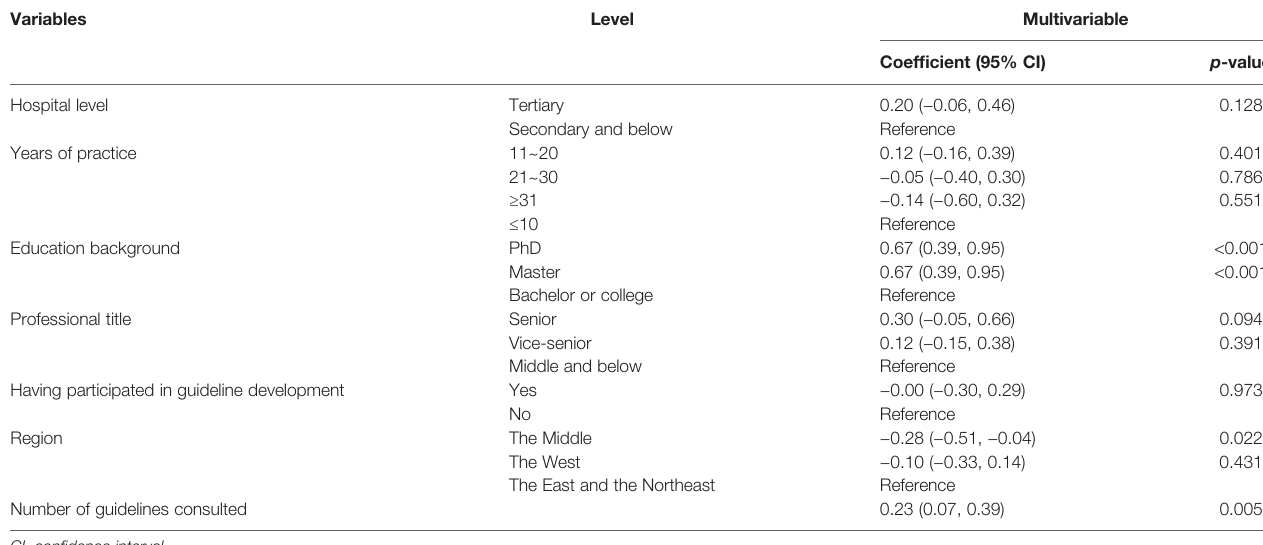
TABLE 3 | Multivariable linear regressions of knowledge of guidelines.